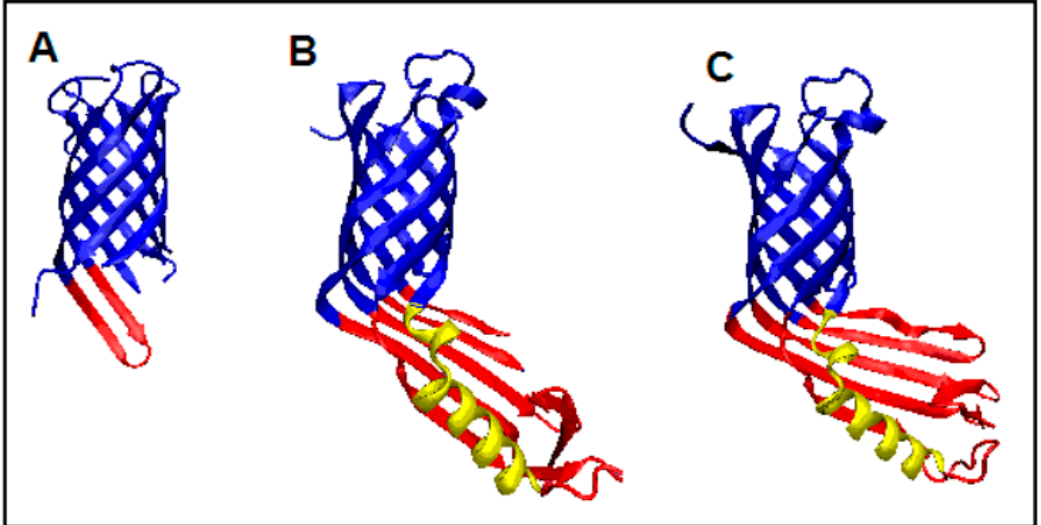
Figure 9. 3D presentation of experimentally modified membrane protein structures showing the different statuses of the out-barrel part red. The helix distinguisher is in yellow. ( A ) 2RLC, ( B ) 2RL9, and ( C ) 2RLB.